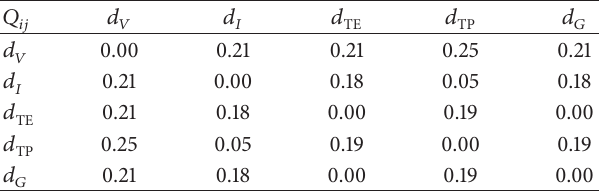
Table 4: Weighted generalized distance.